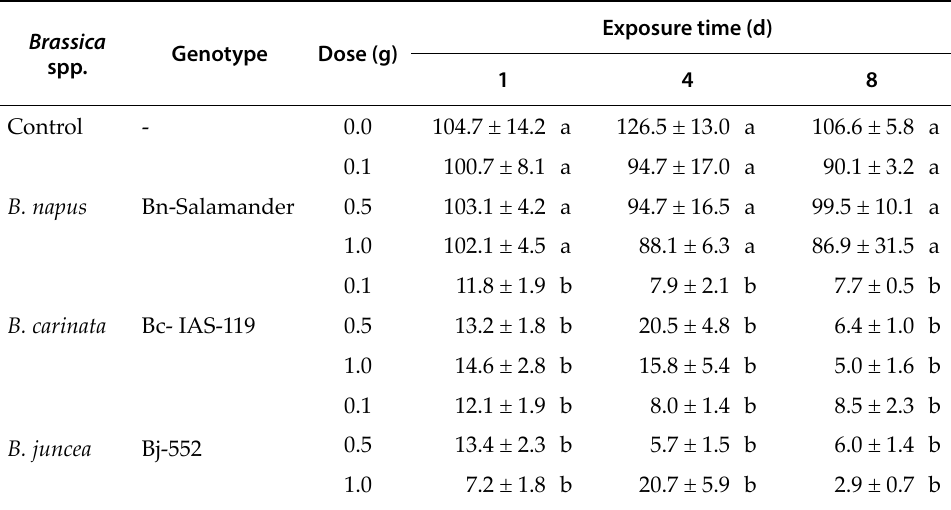
Table 4. Average numbers (± SE) of viable Phytophthora cinnamomi chlamydospores (CFU g -1 of dry soil) after soil exposure to volatiles released by different Brassica biofumigants seeds at different doses and exposure times. Values with different letters in each column differ significantly according with Tukey´s HSD test ( P<